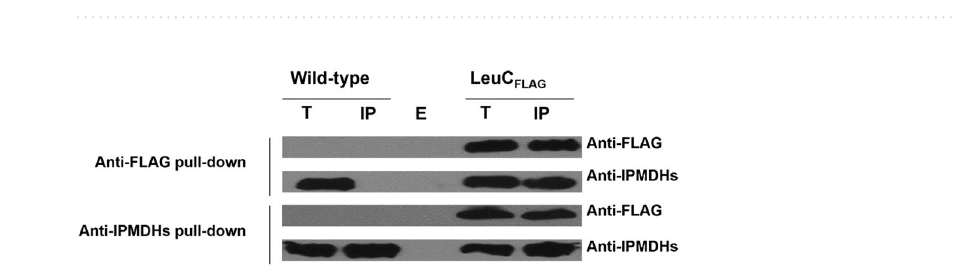
Figure 1. Pair-wise Y2H screening for interactions among nine genes involved in Met chain-elongation pathway. ( A ) Combinations of proteins used in Y2H assay. Transformed yeast with indicated plasmid combinations was plated onto SD media lacking Trp and Leu. Plasmids pPC97 and pPC86 carry GAL4DNA binding domain and GAL4 activation domain, respectively. ( B ) Transformed yeast with indicated plasmid combinations was plated onto SD media lacking Trp, Leu, His and containing 1 mM 3-Amino-1,2,4- Trizaole (3AT).